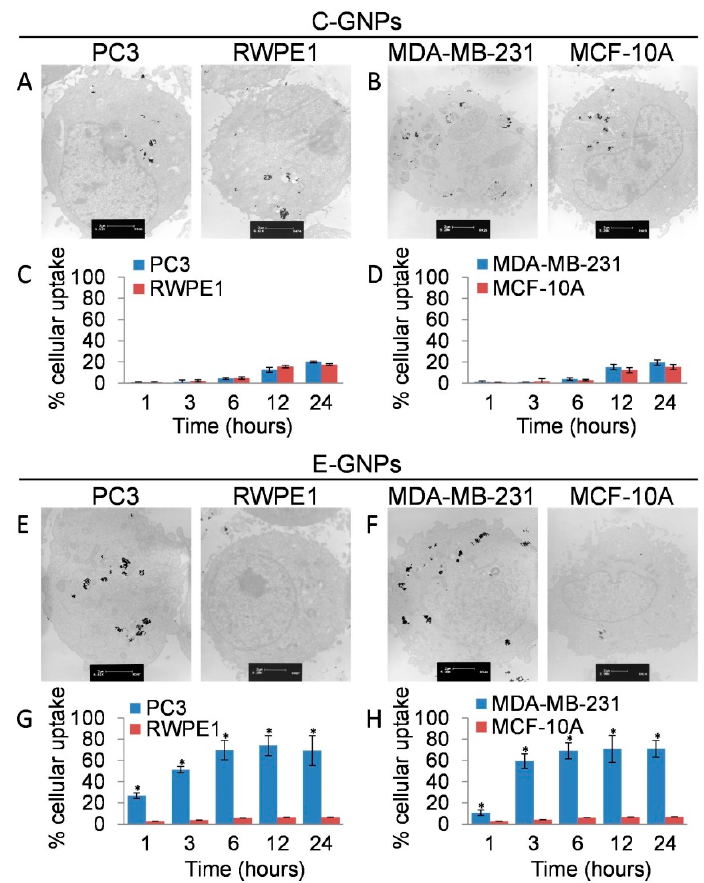
Figure 3. Cancer cells internalize E-GNPs more efficiently. TEM images of PC3 and RWPE1 cells after 24 h treatment with C-GNPs ( A ) and E-GNPs ( E ) at 50 µ g/mL concentration. TEM images of MDA-MB-231 and MCF-10A cells after 24 h treatment with C-GNPs ( B ) and E-GNPs ( F ) at 50 µ g/mL concentration. Atomic absorption spectroscopy (AAS) analysis data from PC3 and RWPE1 cells show time-dependent cellular uptake of C-GNPs ( C ) and E-GNPs ( G ). AAS analysis data from MDA-MB-231 and MCF-10A cells shows time-dependent cellular uptake of C-GNPs ( D ) and E-GNPs ( H ). Bars represent the mean of triplicates ± SD, * p <